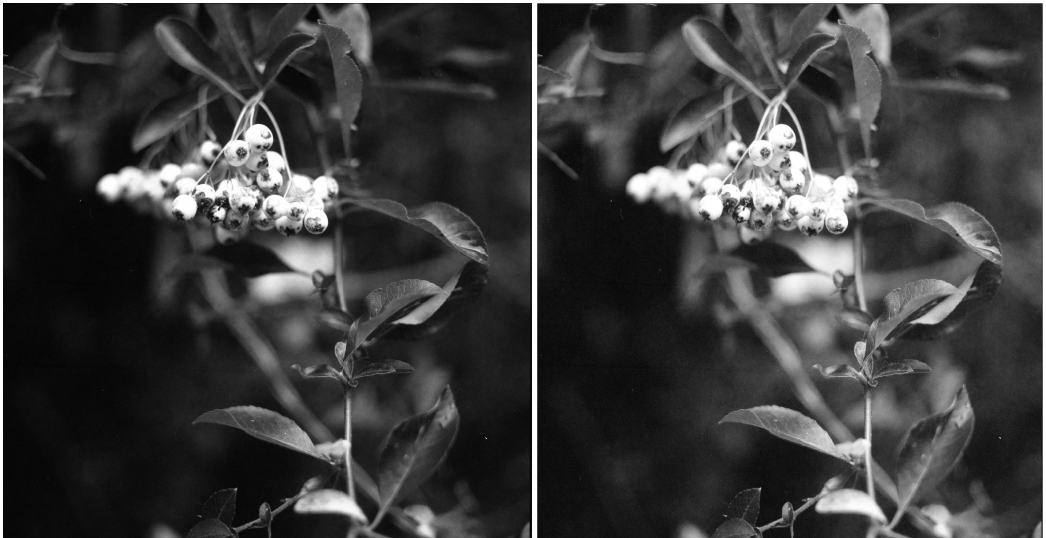
Figure A1. Example of the image lightness scaling applied to the photographs to produce more effectively spaced Woodburytype prints. This represents only the cyan component of the final full colour